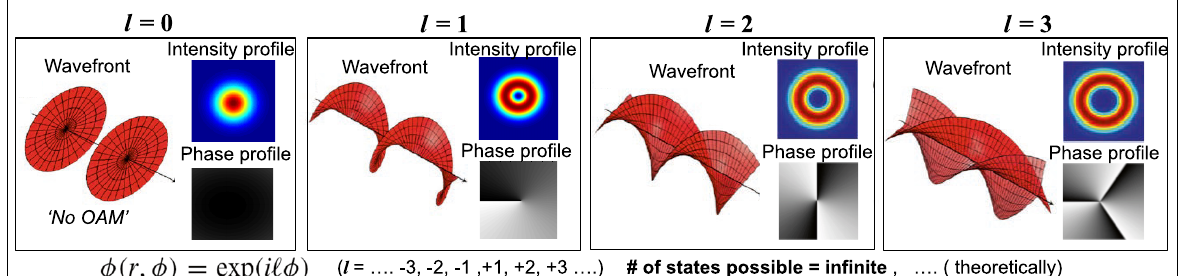
Figure 1: The wavefronts, intensity profiles, and phase profiles of orbital angular momentum (OAM) modes l = 0, 1, 2, and 3. The OAM mode withanonzeroorderhasadonutshapeintensitypro fi leandhelicalphasefront.Thesizeoftheringintheintensitypro fi legrowswith l. Wenote that p + 1 represents the number of concentric amplitude rings and p =0 is shown.